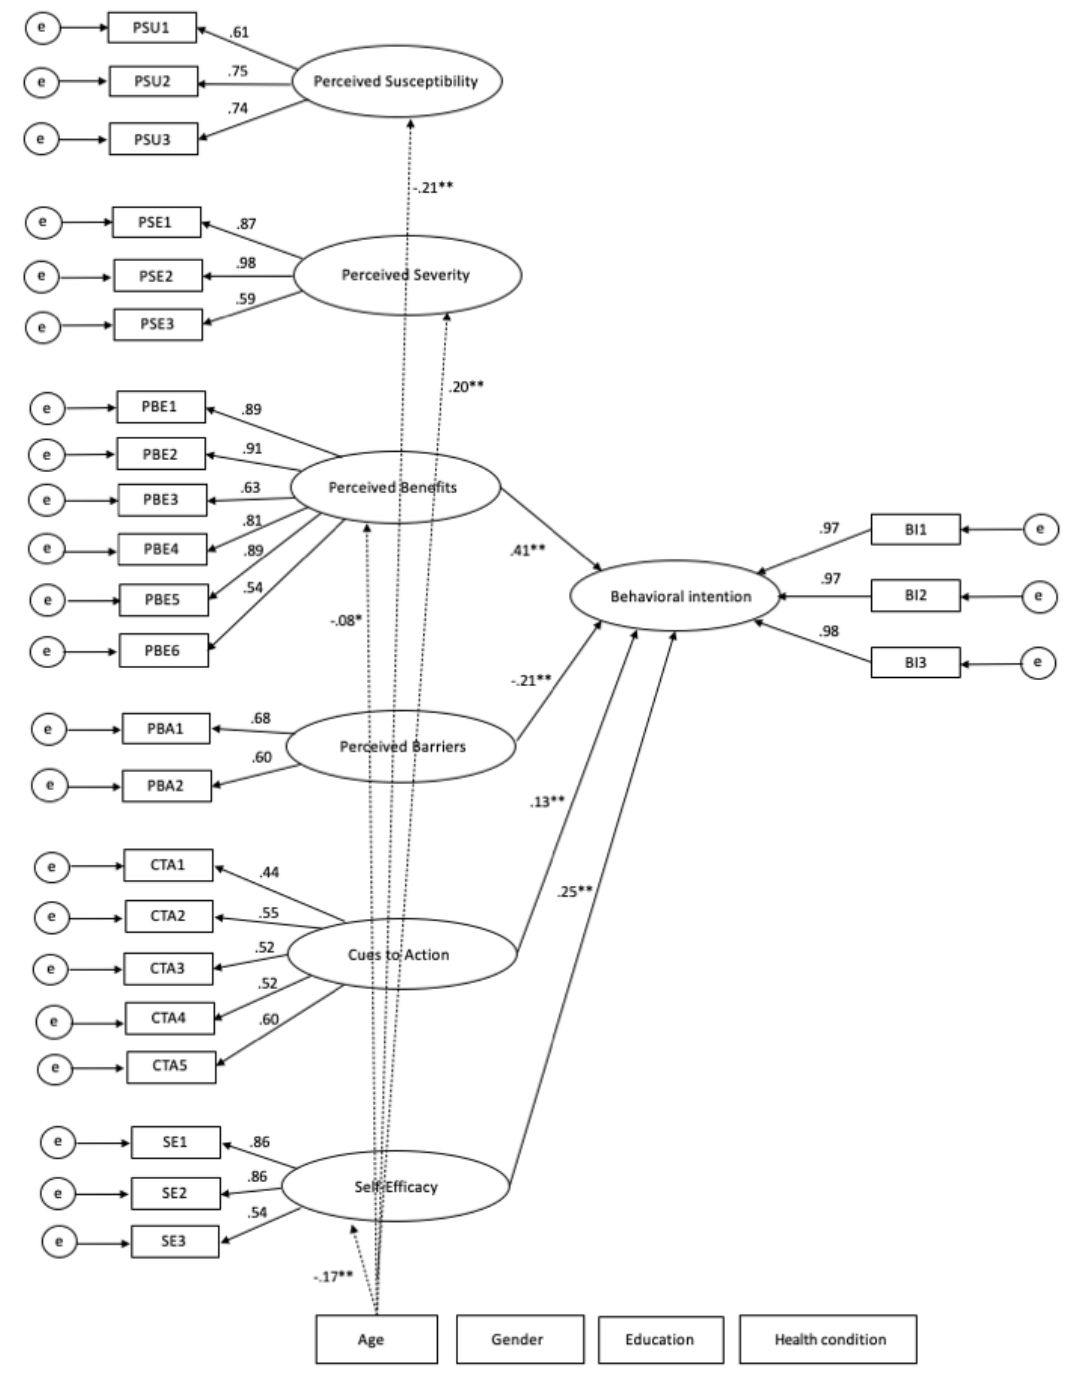
Figure 1. Structural model. Nonsignificant paths are not included. Dashed lines refer to covariates. * P <.01 ** P